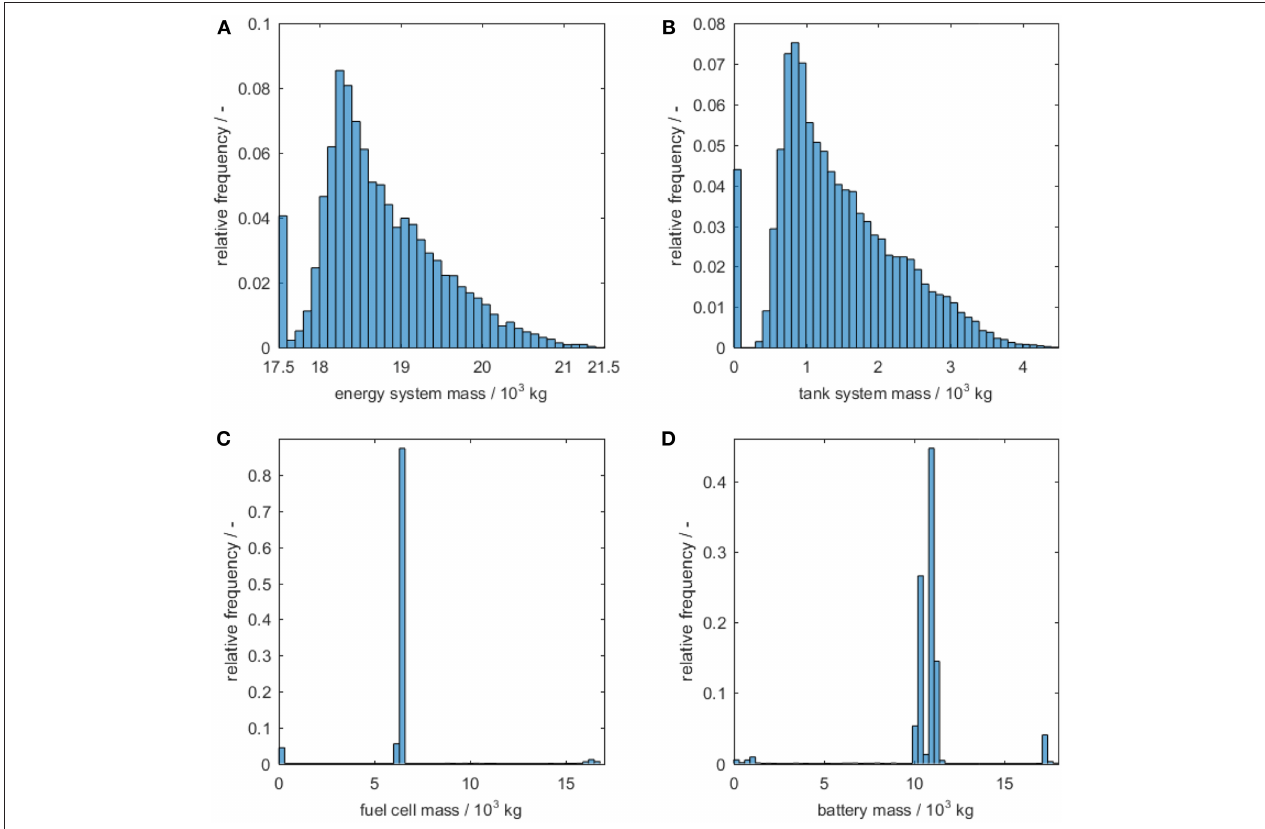
FIGURE 6 | Energy system design for the A320 for current fuel cell systems with a specific power of 1.6 kW/kg and advanced batteries with a specific energy of 0.8 kWh/kg. Distribution of: (A) the total mass of the energy system, (B) mass of the tank system (tank + hydrogen), (C) fuel cell mass, and (D) battery